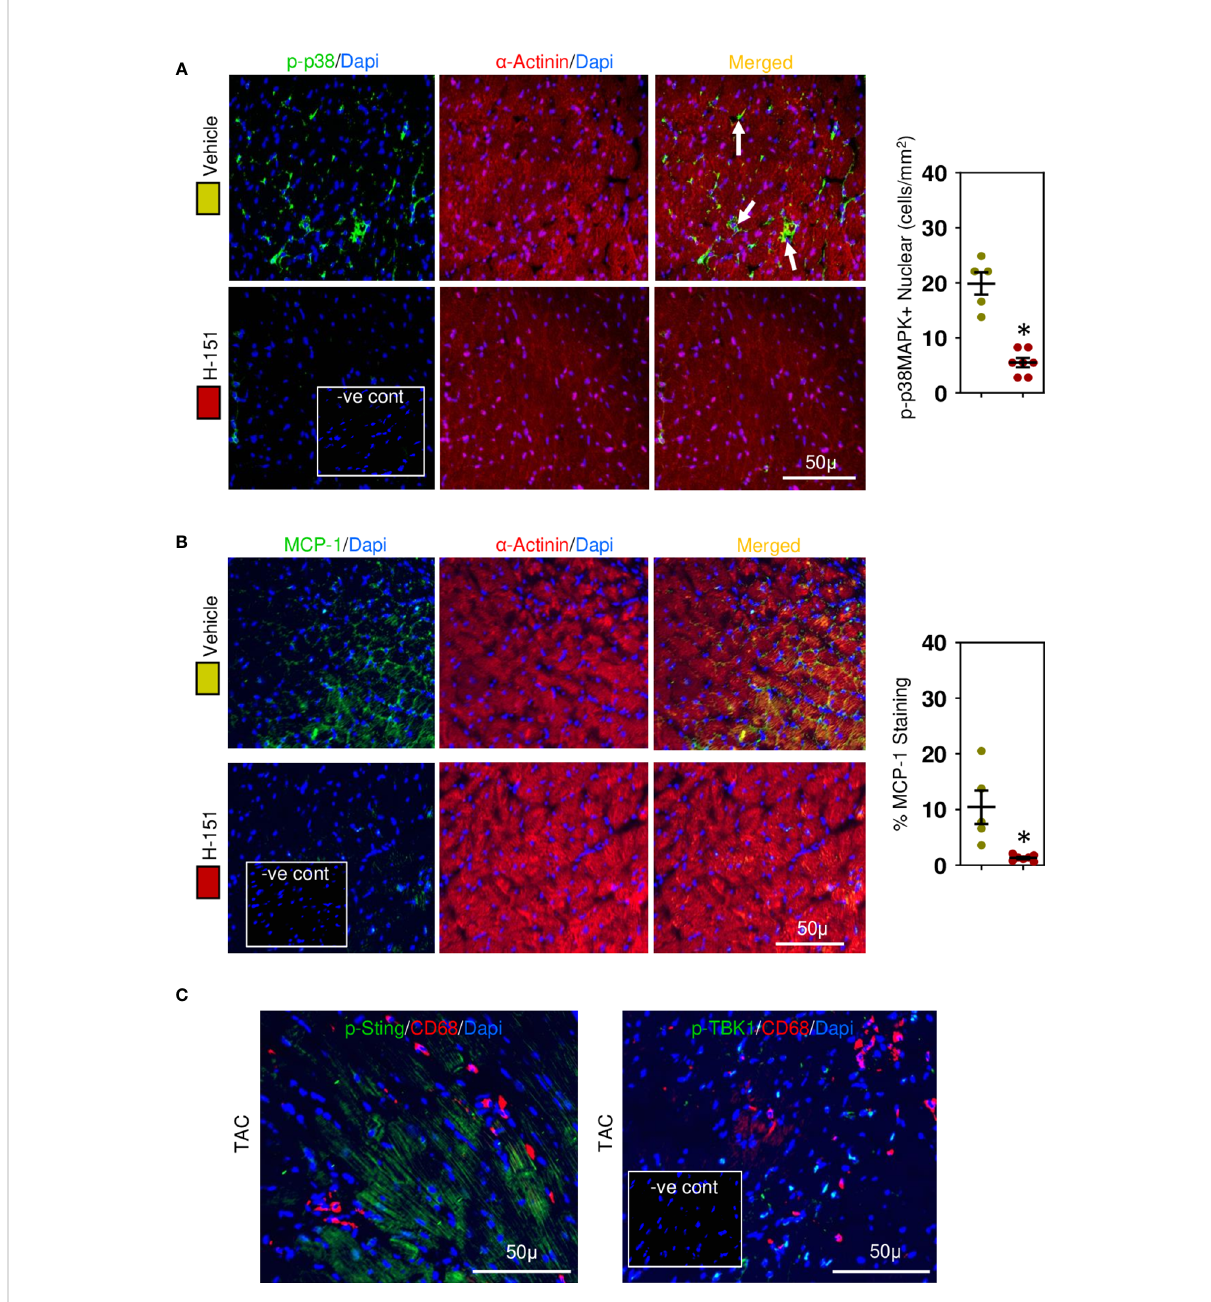
FIGURE 8 Cardiac phospho-p38MAPK and MCP-1 are upregulated in hypertensive cardiac fi brosis. (A) Nuclear phospho-p38MAPK is increased in cardiomyocytes during fi brosis development and inhibited by H-151. (B) Cardiomyocyte MCP-1 expression is increased during fi brosis development and prevented by H-151. (C) Macrophages associated with cardiac fi brosis do not express phosphoSTING or phosphoTBK1. Results are means ± SEM with small circles represent data from individual mice. n=5-7/group. -ve control; no primary antibody control, scale bar represents 50µm. *P< 0.05 from control TAC mice treated with vehicle only using two tailed Student ’ s t-test, comparing to